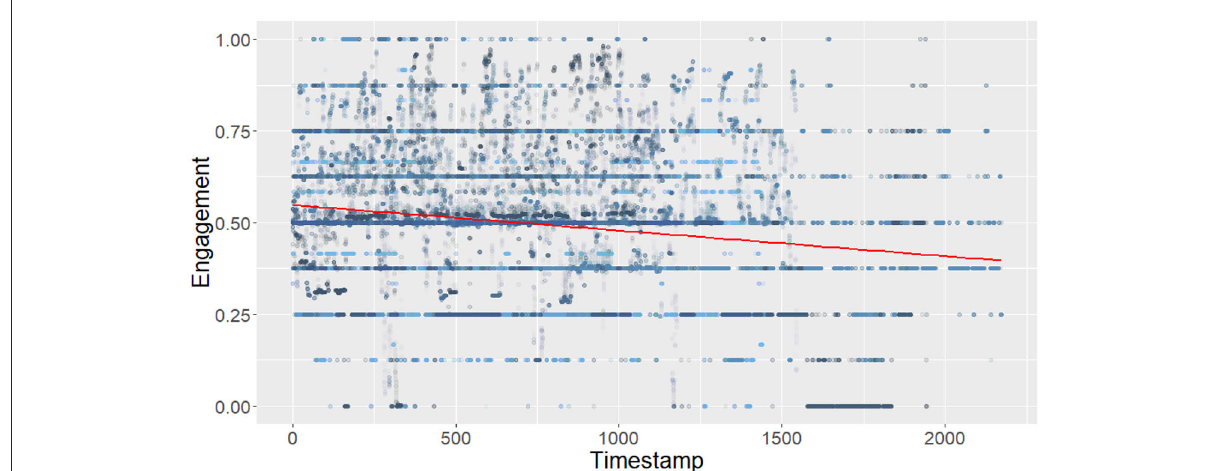
FIGURE2 Evolution of engagement over time in NoXi.